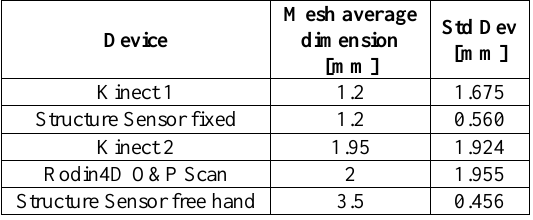
Table 5. Values of mesh size and standard deviation of the cloud to mesh distance for the thigh models in respect to the one acquired with Minolta Vivid 9i.